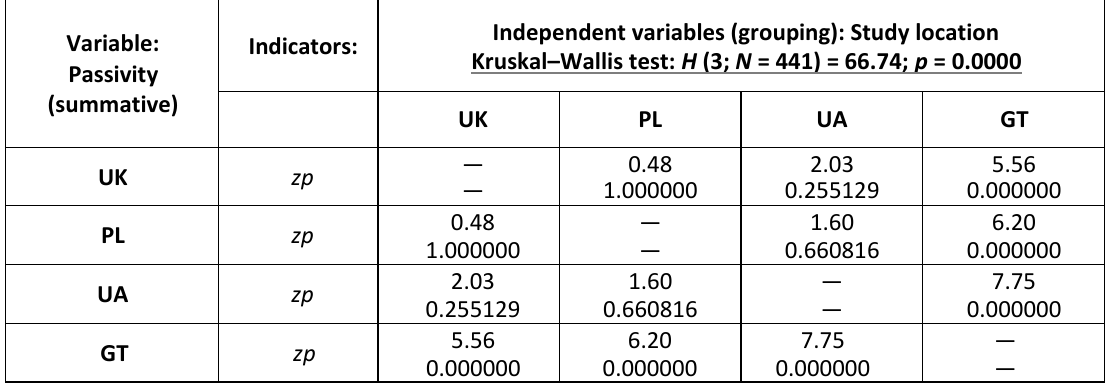
Table 3. Post-hoc tests for passivity